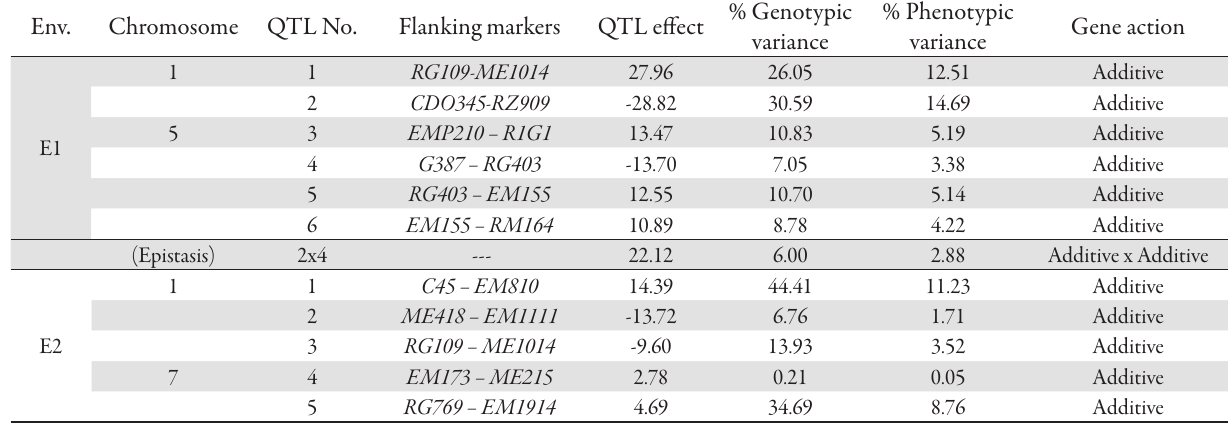
Tab. 2. Estimates of QTL effects and percent variance explained by each QTL in MIM model for grain yield in rice under two water stress environments (E1 and E2)